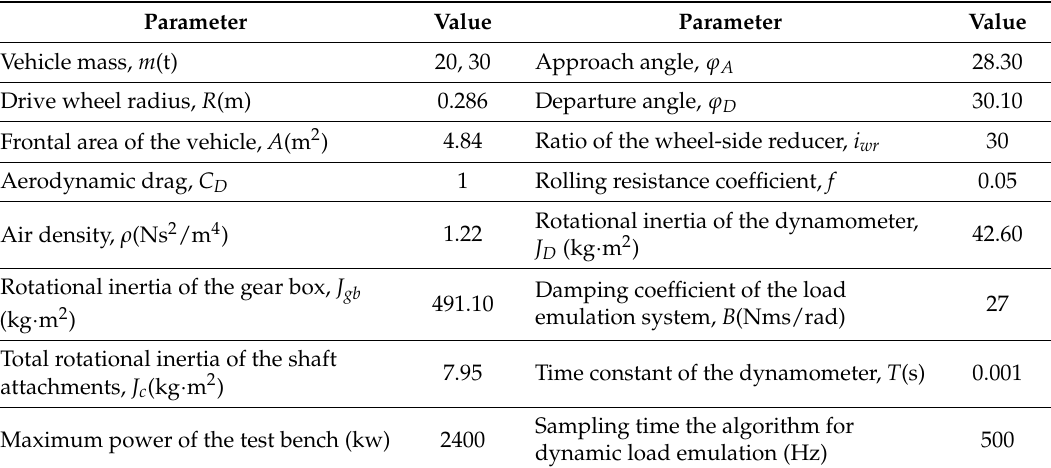
Table 1. Major parameters of the tested DDTV and test